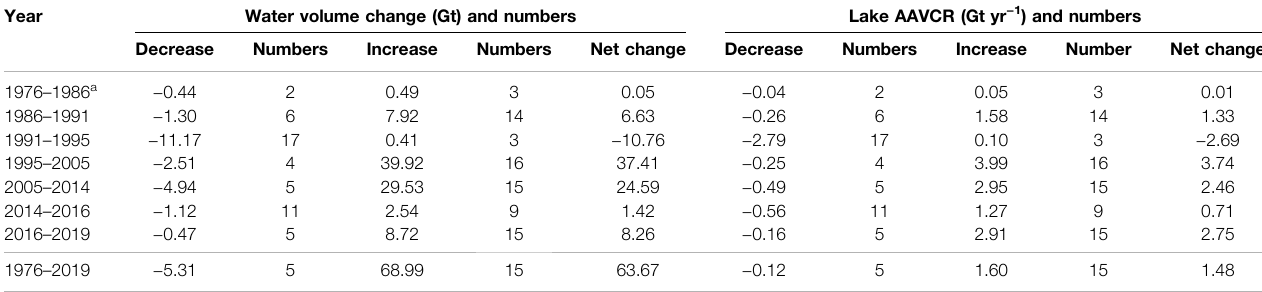
TABLE 3 | Lake volume change and Annual Average Volume Change Rate (AAVCR) in different periods during the period 1976 –